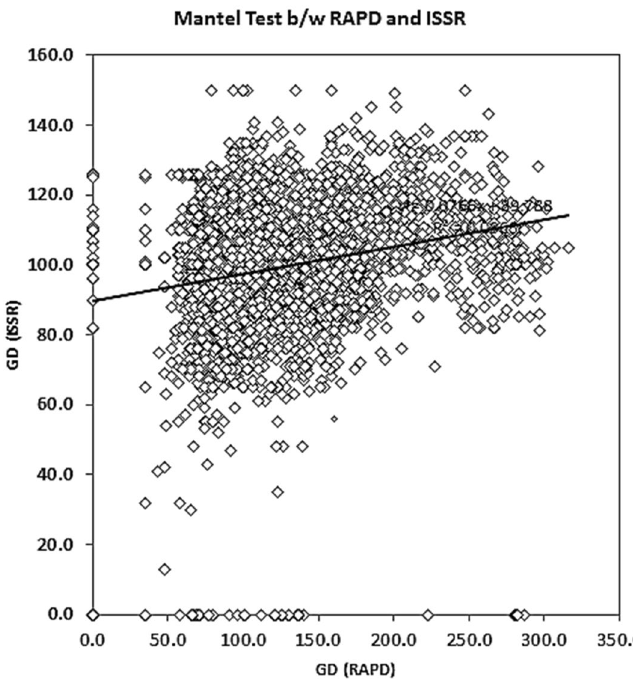
Figure 2. Mantel test for the 91 Trichoderma spp. representing the genetic distance between RAPD and ISSR